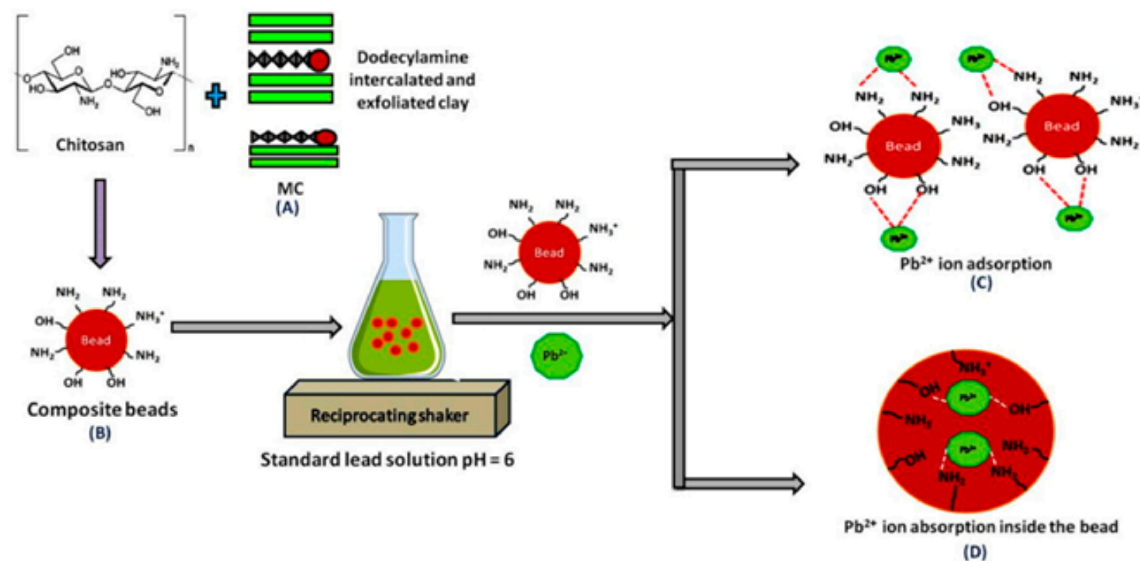
Figure 3. The mechanism of Pb +2 ions removal over chitosan-clay composite